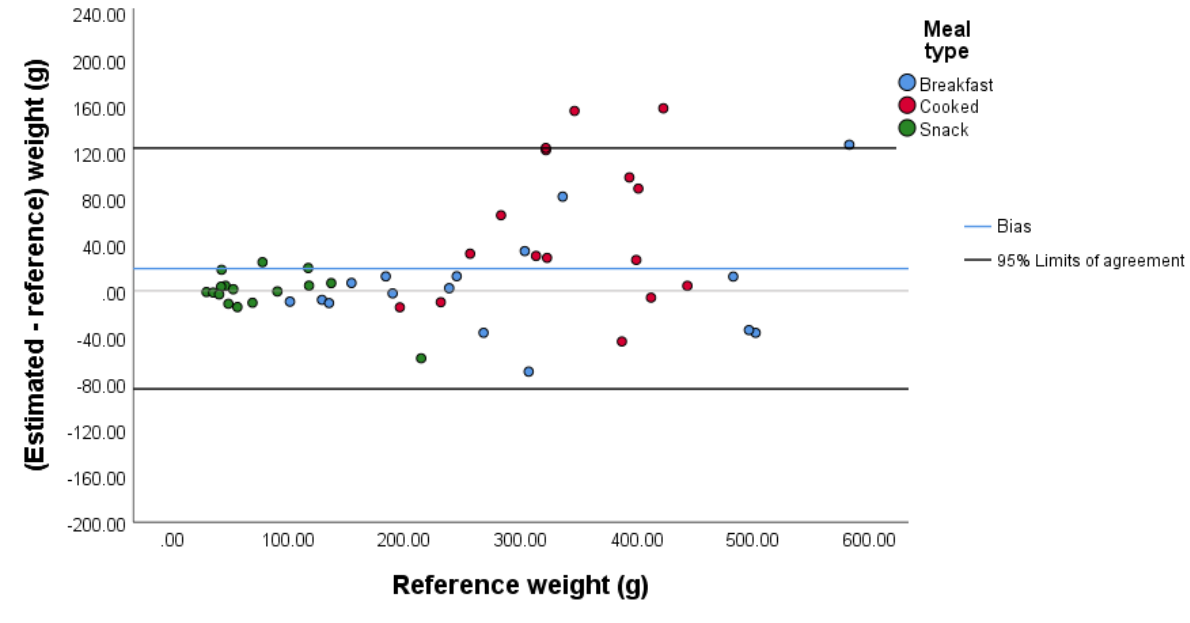
Figure 2. Bland-Altman plot illustrating the difference between the estimated and reference meal weights.